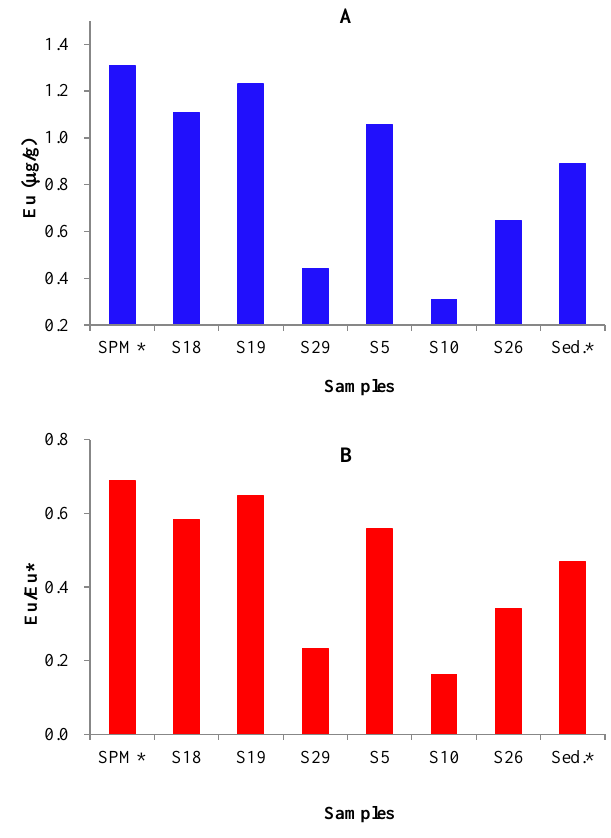
Fig. 7. (A) Distribution of rare earth elements in the sinking parti- cles of the ECS. (B) Normalized Eu distribution in the sinking par- ticles of the ECS. The Eu ∗ (1.90 ± 0.07µgg − 1 ) in Fig. 7 was the average value of Eu ∗ in both sediment (1.85µgg − 1 ) and suspended particle (1.95µgg − 1 ) , which was referred to from the Table 4 of Zhang et al. (1998), who obtained a linear interpolation between Sm and Tb on the chondrite-normalized